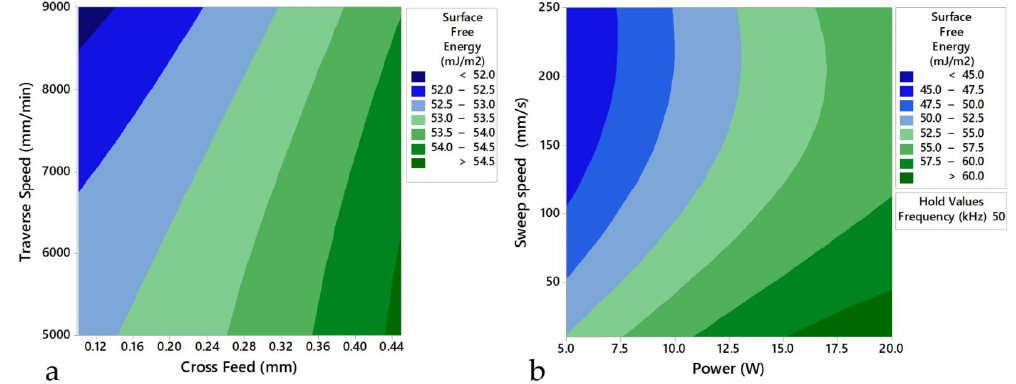
Figure 16. Contour diagrams of the surface free energy values obtained for: ( a ) Abrasive water jet texturing; ( b ) Laser texturing.